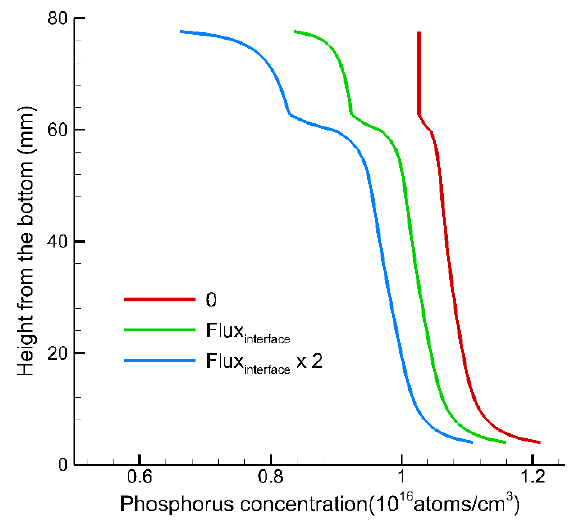
Figure 9. Distribution of the phosphorus concentration in the center of the melt along the vertical direction with different evaporation fluxes at the melt surface one hour after the start of solidification. The phosphorus evaporation flux at the melt surface was (i) 0, (ii) the same as the phosphorus incorporation flux at the melt–crystal interface, and (iii) twice as large as that of case (ii).